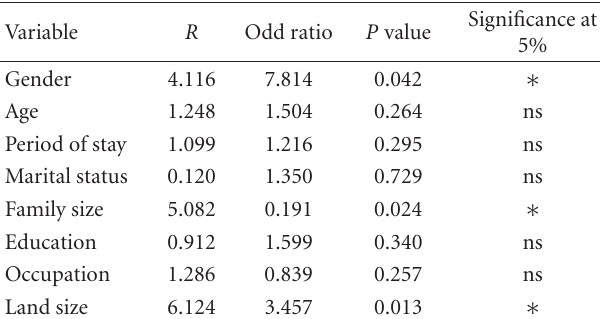
Table 4: Logistic regression of sociodemographic characteristics that influence people’s willingness to manage the shea trees ( N = 80).